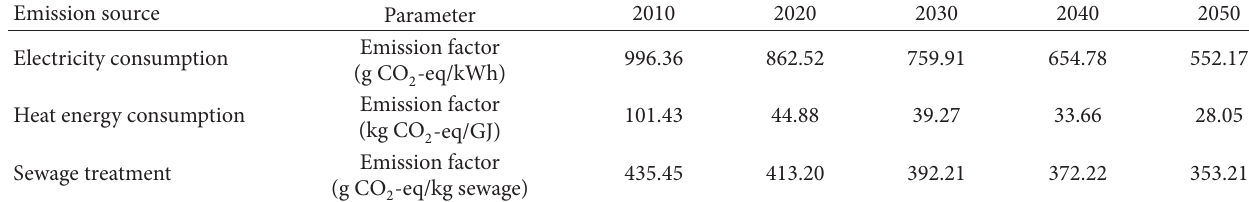
T 1: Scenario analysis of operation stages.